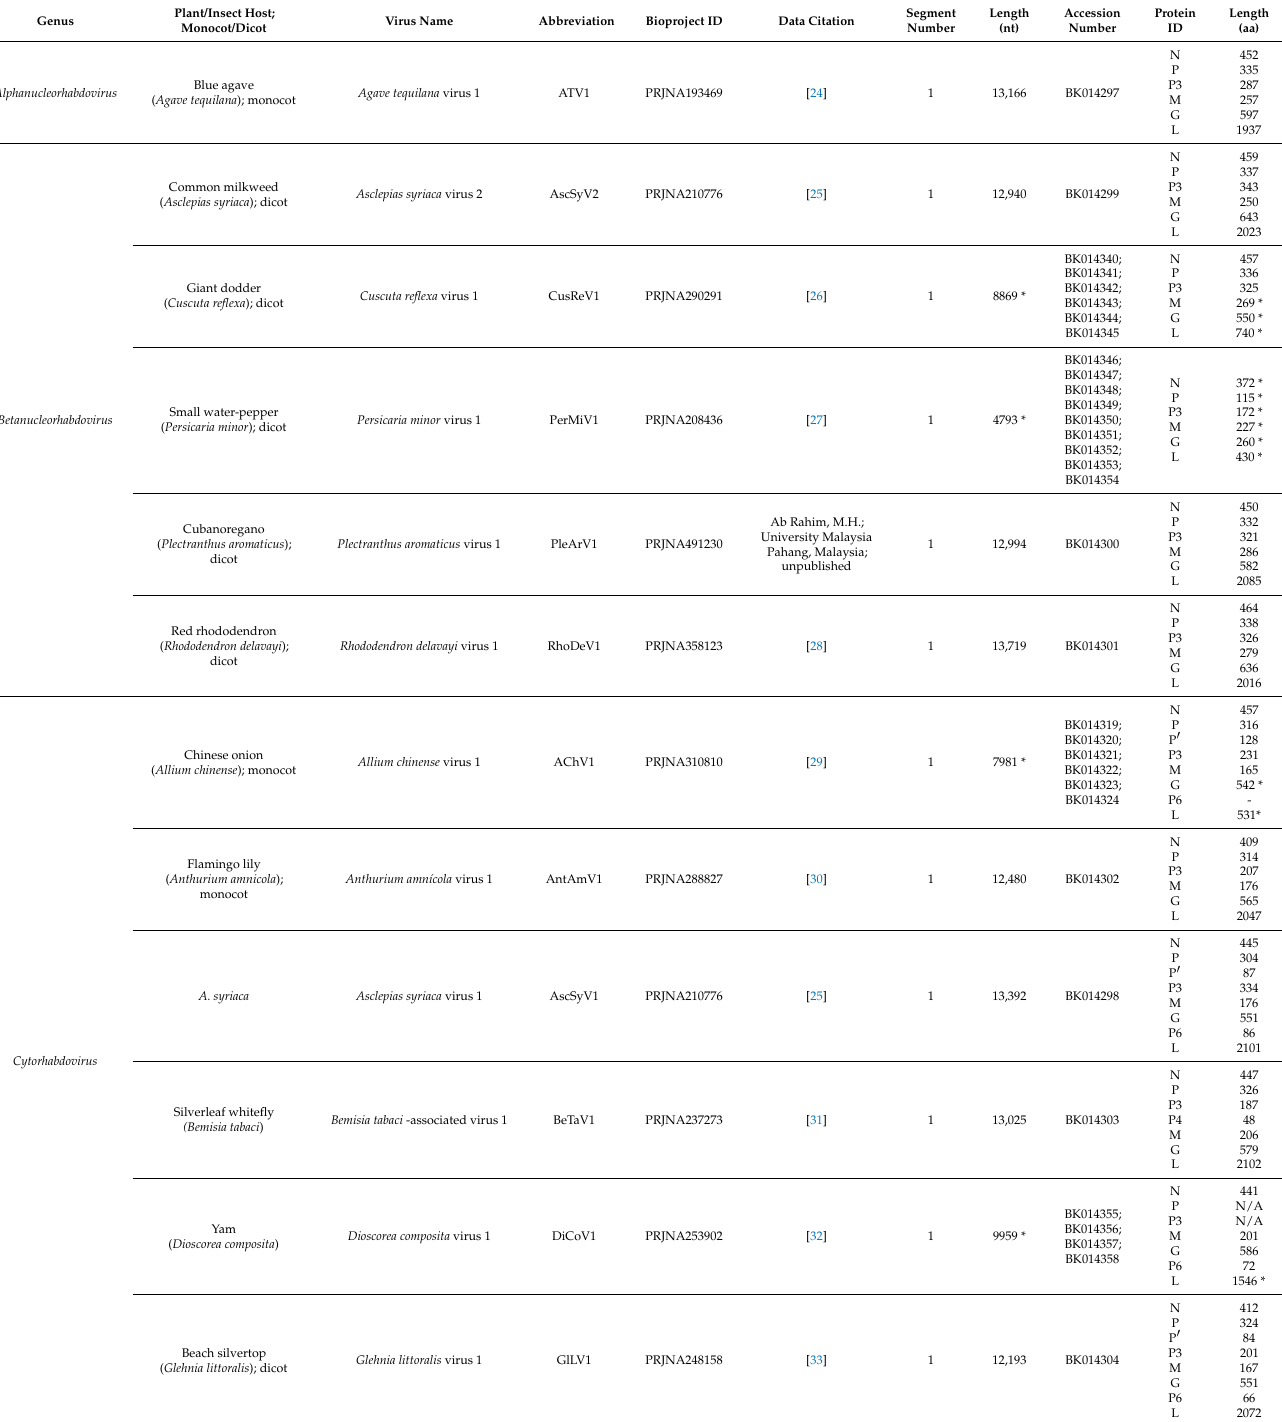
Table 1. Summary of rhabdovirus contigs identified from plant transcriptome data available in the National Center for Biotechnology Information (NCBI)